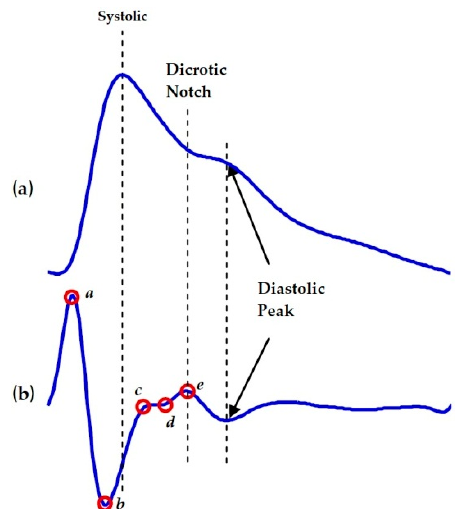
Figure 3. Second derivative of photoplethysmography (SDPPG) [39]. ( a ) Fingertip photoplethysmogram. ( b ) Second derivative wave of photoplethysmogram. The photoplethysmogram waveform consists of one systolic wave and one diastolic wave, while the second derivative photoplethysmogram waveform consists of four systolic waves (a, b, c, and d waves) and one diastolic wave (e